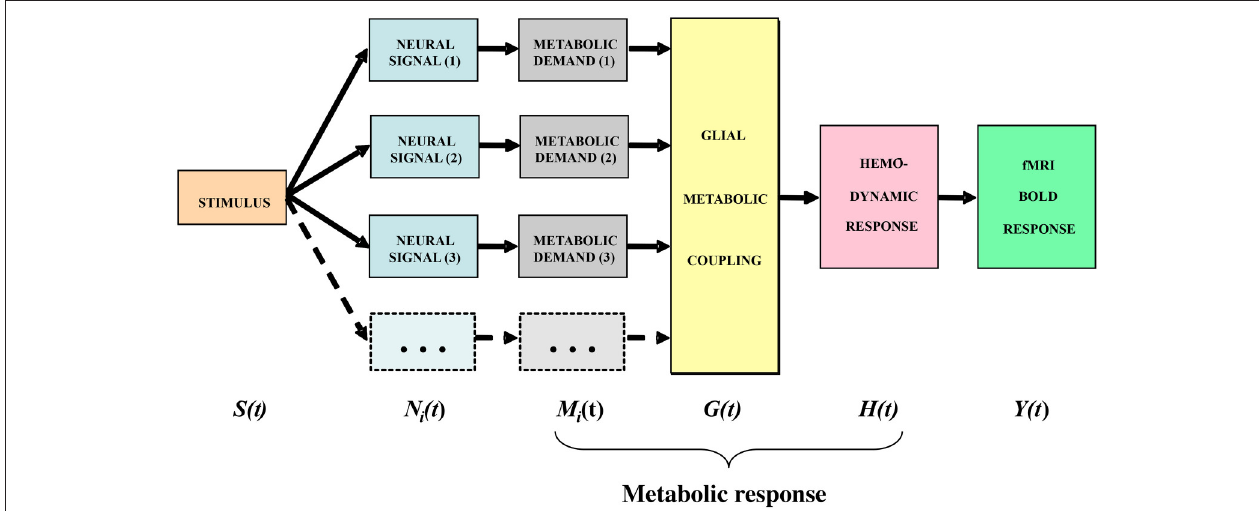
FIGURE 3 | Block diagram of the main processing stages that lead up to the BOLD signal. The subscript i indicates that the stage incorporates multiple components from homogeneous subpopulations within a voxel (from Tyler and Likova, 2011, 2014).